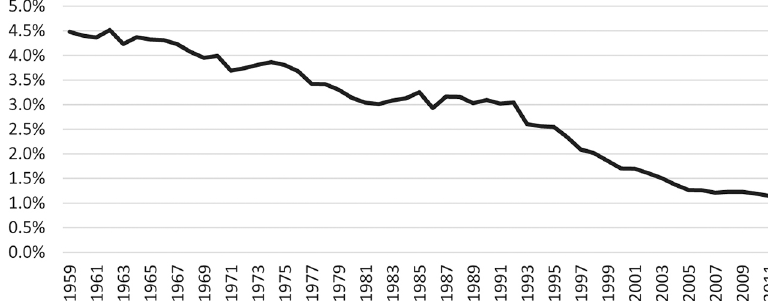
Figure 1: United Funds/Way giving as % of total US Giving (Data from Hall and Burke (2006), United Way, & Giving